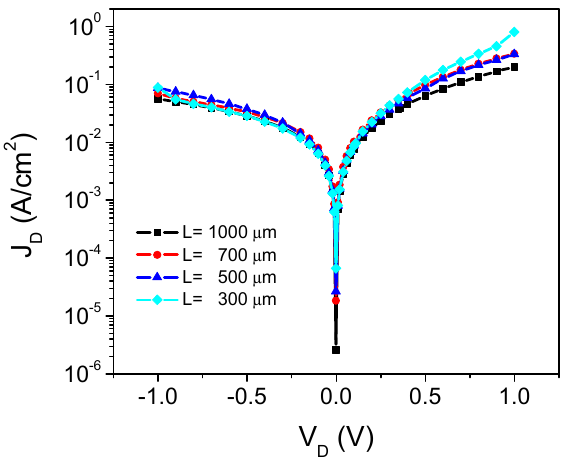
Figure 1. Plot of the J D – V D characteristic for the different length devices. The diode area is defined as A = L 2 . Table 2. Summary of the extracted Schottky barrier diode through the different extraction procedures. Diode Length ( µ